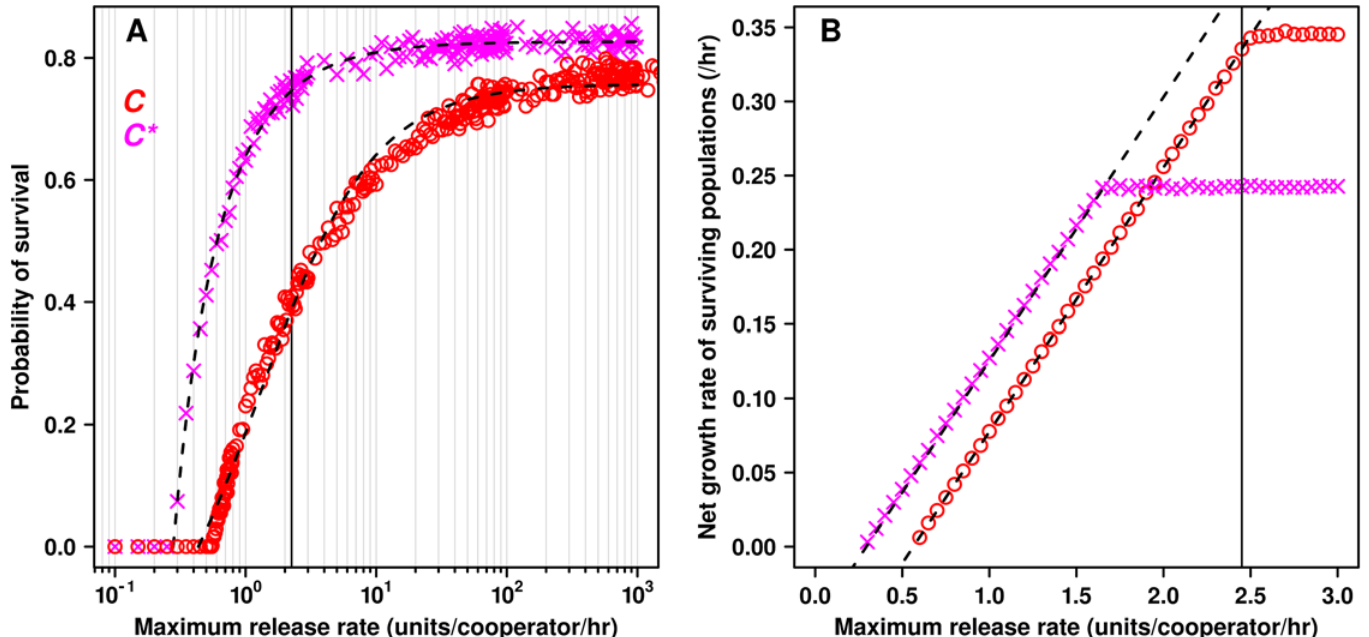
Fig 2. Resource release rate determines multiple aspects of fitness. Individual locations ( n = 1024) were seeded with a single C (red circles) or C * (magenta X's) individual, no initial resource, no cooperator to defector mutation, and no migration. Simulations were run until every location had a population size of 0 (i.e., extinction) or (cid:6) 10 3 individuals. The maximal release rate β 0j = 2.4 units/cooperator/hr used in most simulations is marked by a solid black line. A ) The relationship between survival probability and maximum release rate β was fit to the equation ( p max ( β - h ))/( k+ ( β - h )) using non-linear least squares regression (black dotted line). Here p max was the maximum probability of survival, h was the smallest maximal release rate β allowing any surviving populations, and k was the β - h value allowing half-maximal probability of survival. Only rates giving survival probabilities > 0 were considered. For C , the parameter values were found to be p max = 0.757 (0.754 – 0.760); k = 1.7 (1.6 – 1.8); h = 0.43 (0.40 – 0.46). For C * , p max = 0.827 (0.824 – 0.829); k = 0.209 (0.201 – 0.217); h = 0.282 (0.276 – 0.288). We calculated the theoretical upper bound of p max for C and found it to be < 0.79 (S1 Appendix), which was in agreement with our simulations. B ) The net growth rates of surviving populations were determined by individually fitting the growth of five populations to the equation A * exp( gt ) using non-linear least squares regression, where A was the initial number of cells after population growth rate had stabilized ( > tens of cells, S1 Fig), g was the net growth rate, and t was the time after the population had reached size A . In all cases, two standard errors were smaller than the plotting points, and were omitted. The net growth rate increased linearly as a function of maximum release rate until the amount released was greater than the amount that could be used by a population growing exponentially at its maximum net growth rate. For both C and C * , the slope of the linear portion (black dashed line) agreed with the theoretical value of 0.18 cooperators per unit of resource (S2